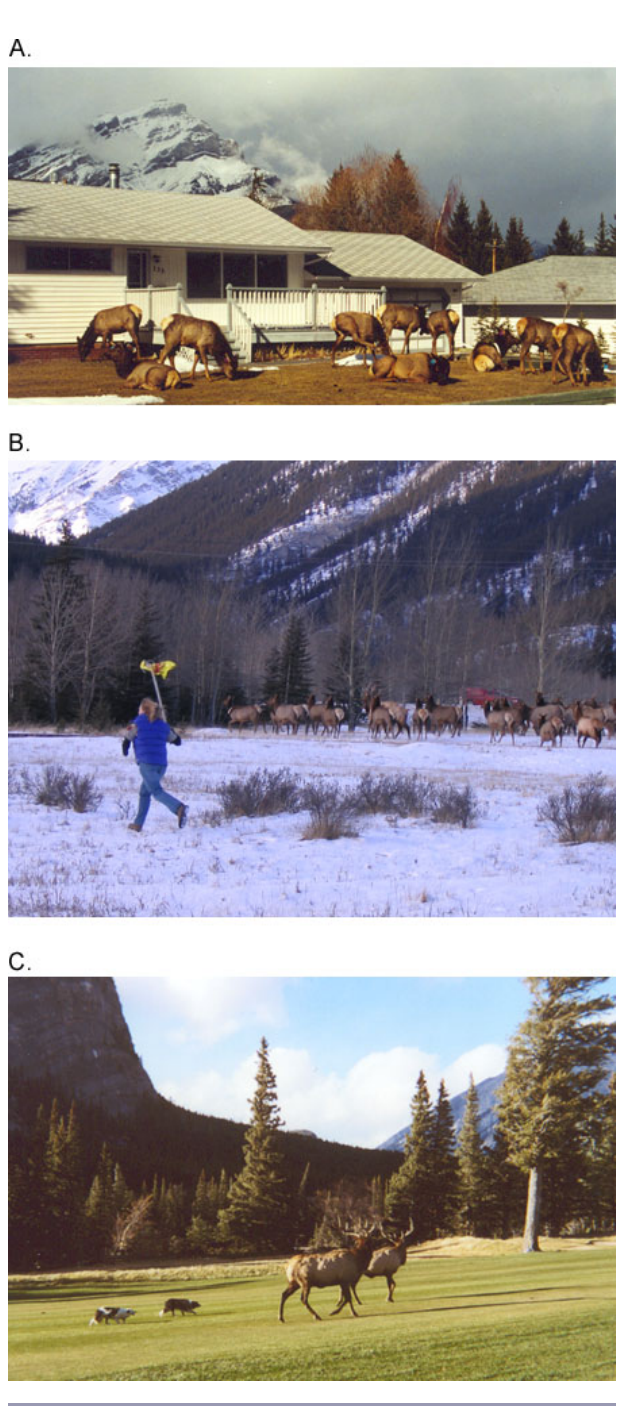
Fig. 1. Habituated elk in Banff National Park (A) prior to aversive conditioning research and during (B) human-based and (C) dog-based conditioning